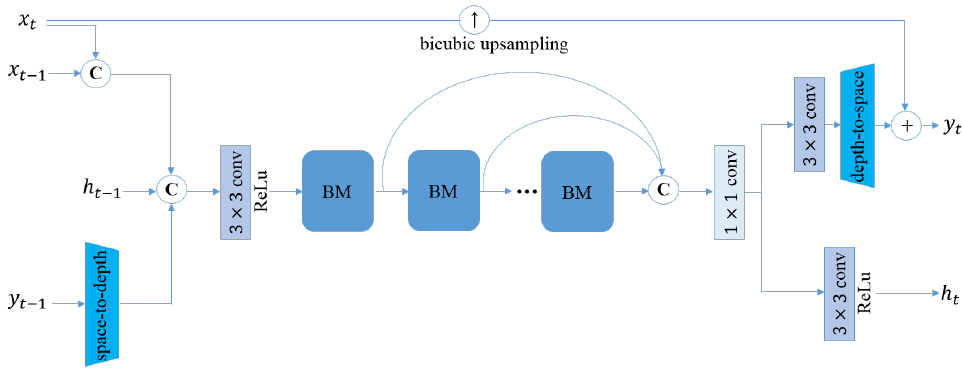
Figure 2. The video super-resolution recurrent network structure proposed in this paper.